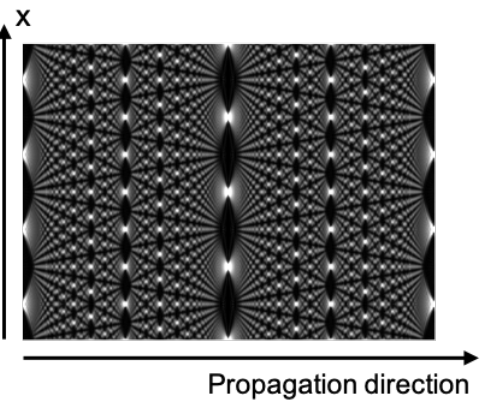
Figure 6. Example of a Talbot carpet pattern created by phase